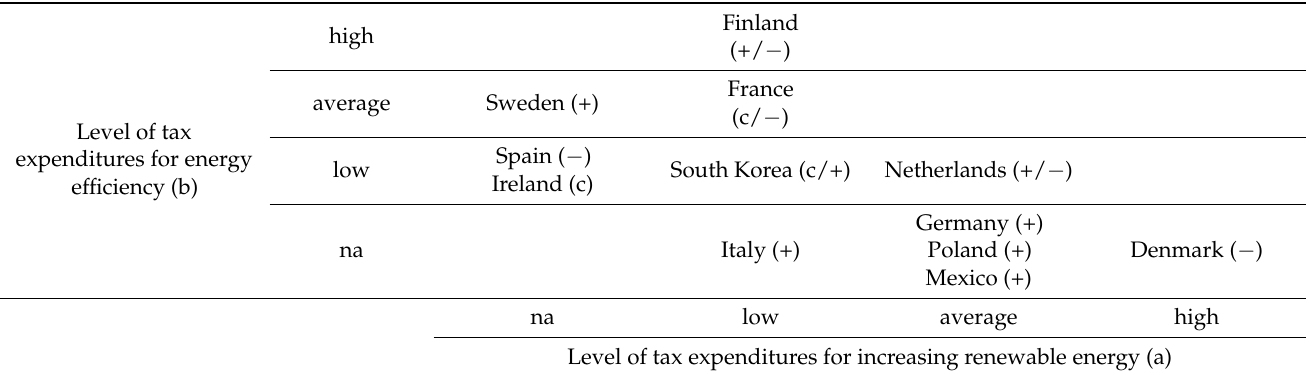
Table 4. Grouping of countries by the level of tax expenditures for the energy efficiency and renewable energy sources, by the share in tax revenues of each country’s consolidated budget.